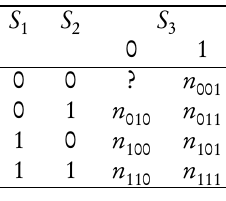
Representation of a 3 sources capture–recapture data.